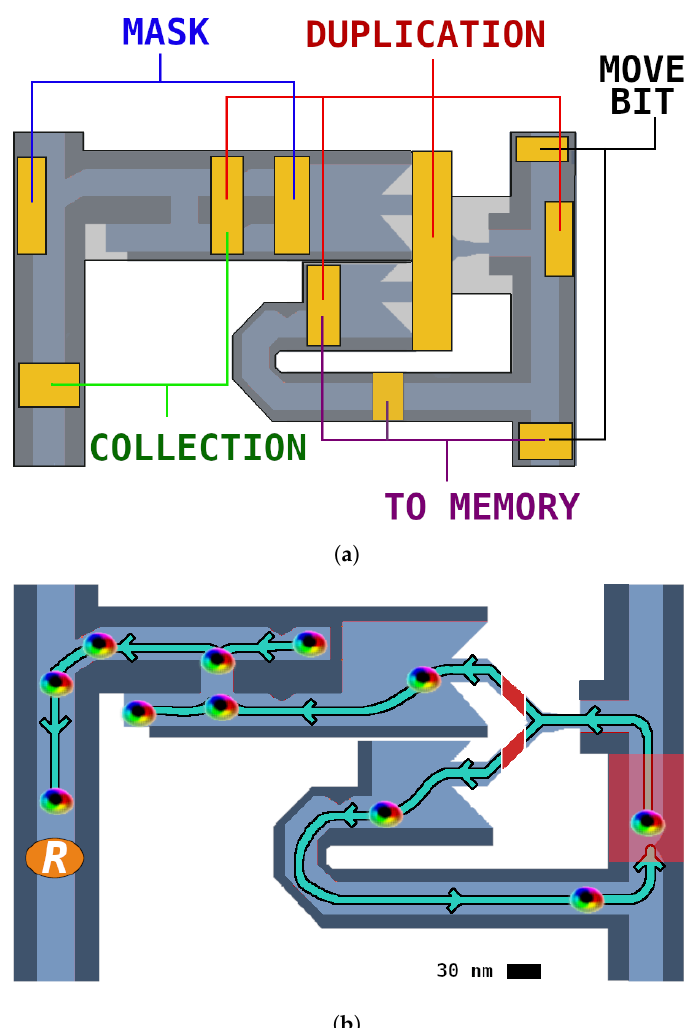
Figure 3. In ( a ), the contacts for current generation in the memory cell. The grey area indicates the tungsten layer. For every operation, a different set of contacts is involved to generate the required local currents to move the skyrmion. In ( b ), the path followed by a skyrmion entering in the processing zone in case a 1 is stored in the cell and the mask bit is set to